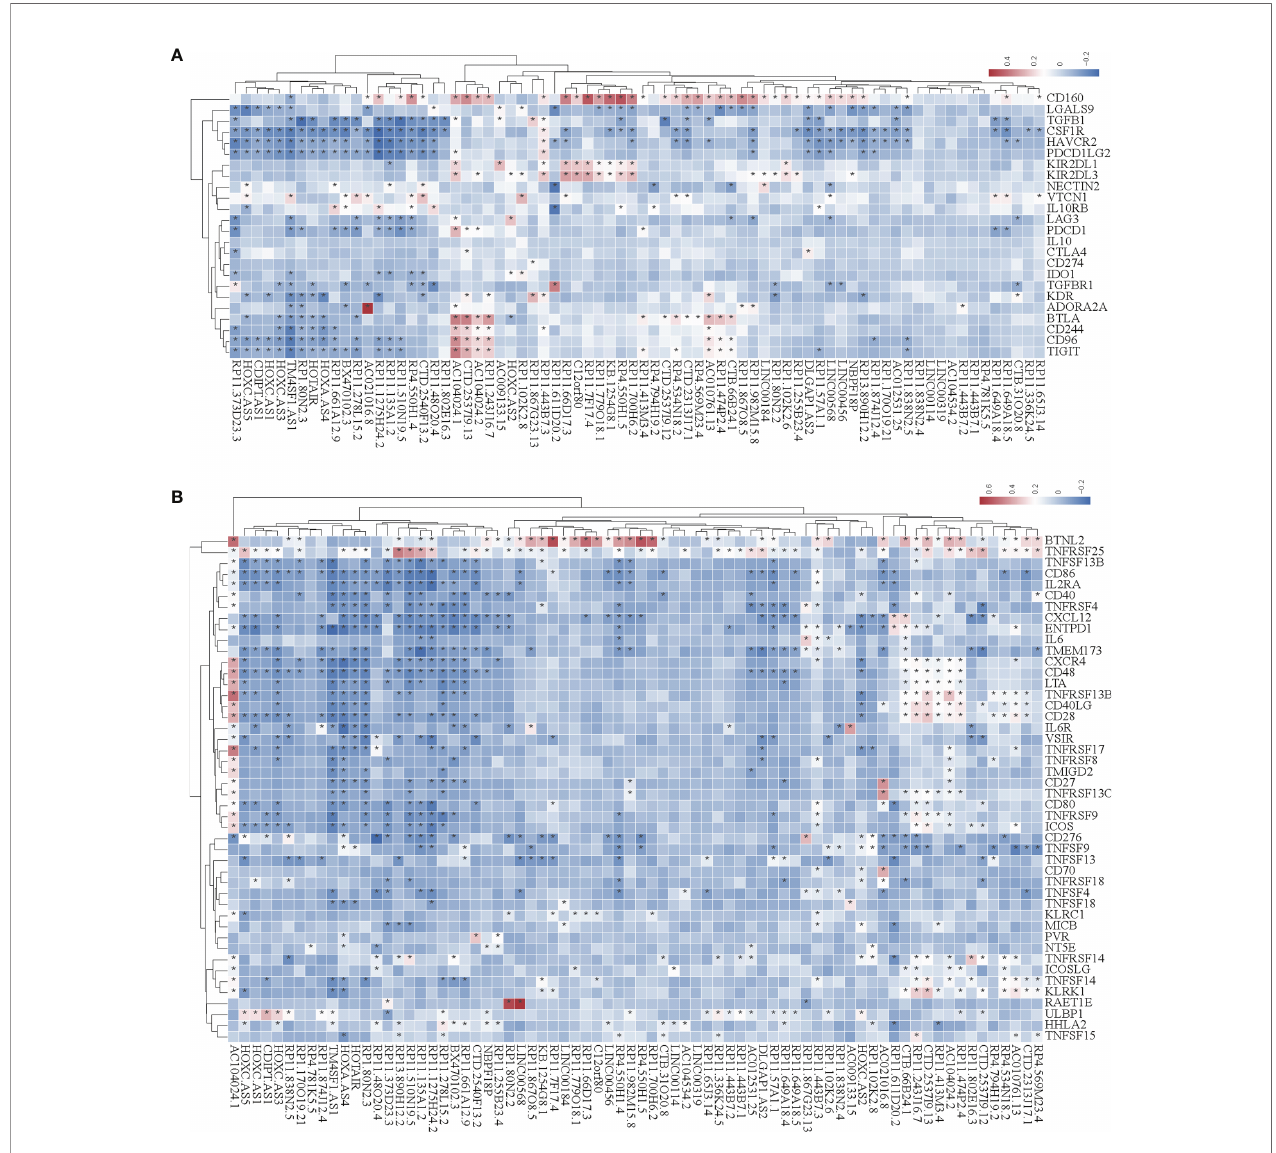
FIGURE 4 | The correlation between the expression of super-enhancer-associated lncRNA and immunomodulators in STAD. (A) Cluster analysis of the expression correlation between 74 SE-associated lncRNAs and immunoinhibitor-related markers. (B) Cluster analysis of the expression correlation between 74 SE-associated lncRNA strands and Immunostimulator-related markers. Red indicates positive correlation, while blue signi fi es negative correlation. The asterisk (*) indicates signi fi cant correlation ( p < 0.05). The list of immunomodulators including immunoinhibitory and immunostimulator was downloaded from TISIDB database (http://cis.hku.hk/TISIDB/download.php). The expression of 74 SE-associated lncRNAs and immunomodulators were downloaded from TCGA database